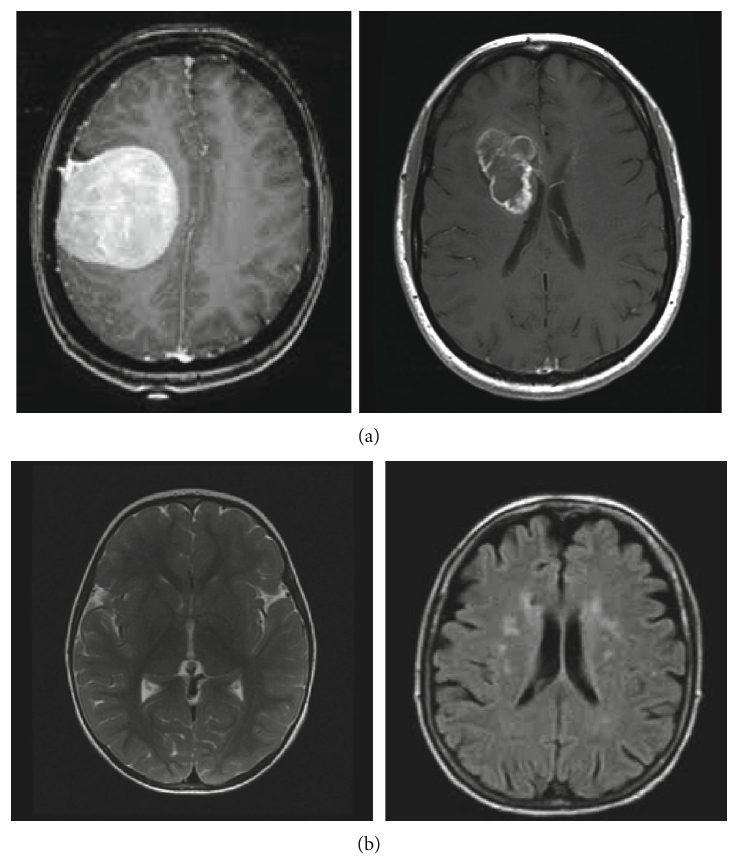
Figure 4: Image of MRI-brain tumor: (a) image of brain tumor patient; (b) nonbrain tumor